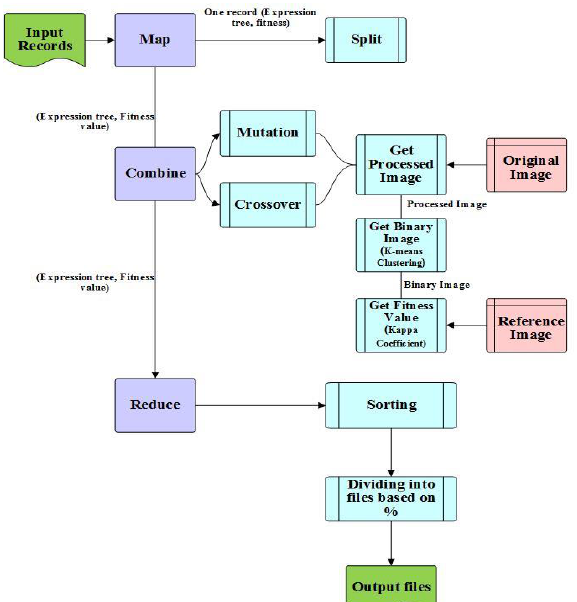
Figure 5. Main steps in the second MapReduce job designed to perform the evolutionary